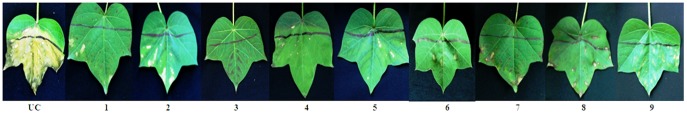
Basta treated leaves of cotton transformants showing tolerance to the herbicide.UC: Untransformed control leaf showing damage to the herbicide. 1–9: Leaves of different cotton transformants showing tolerance to the herbicide.